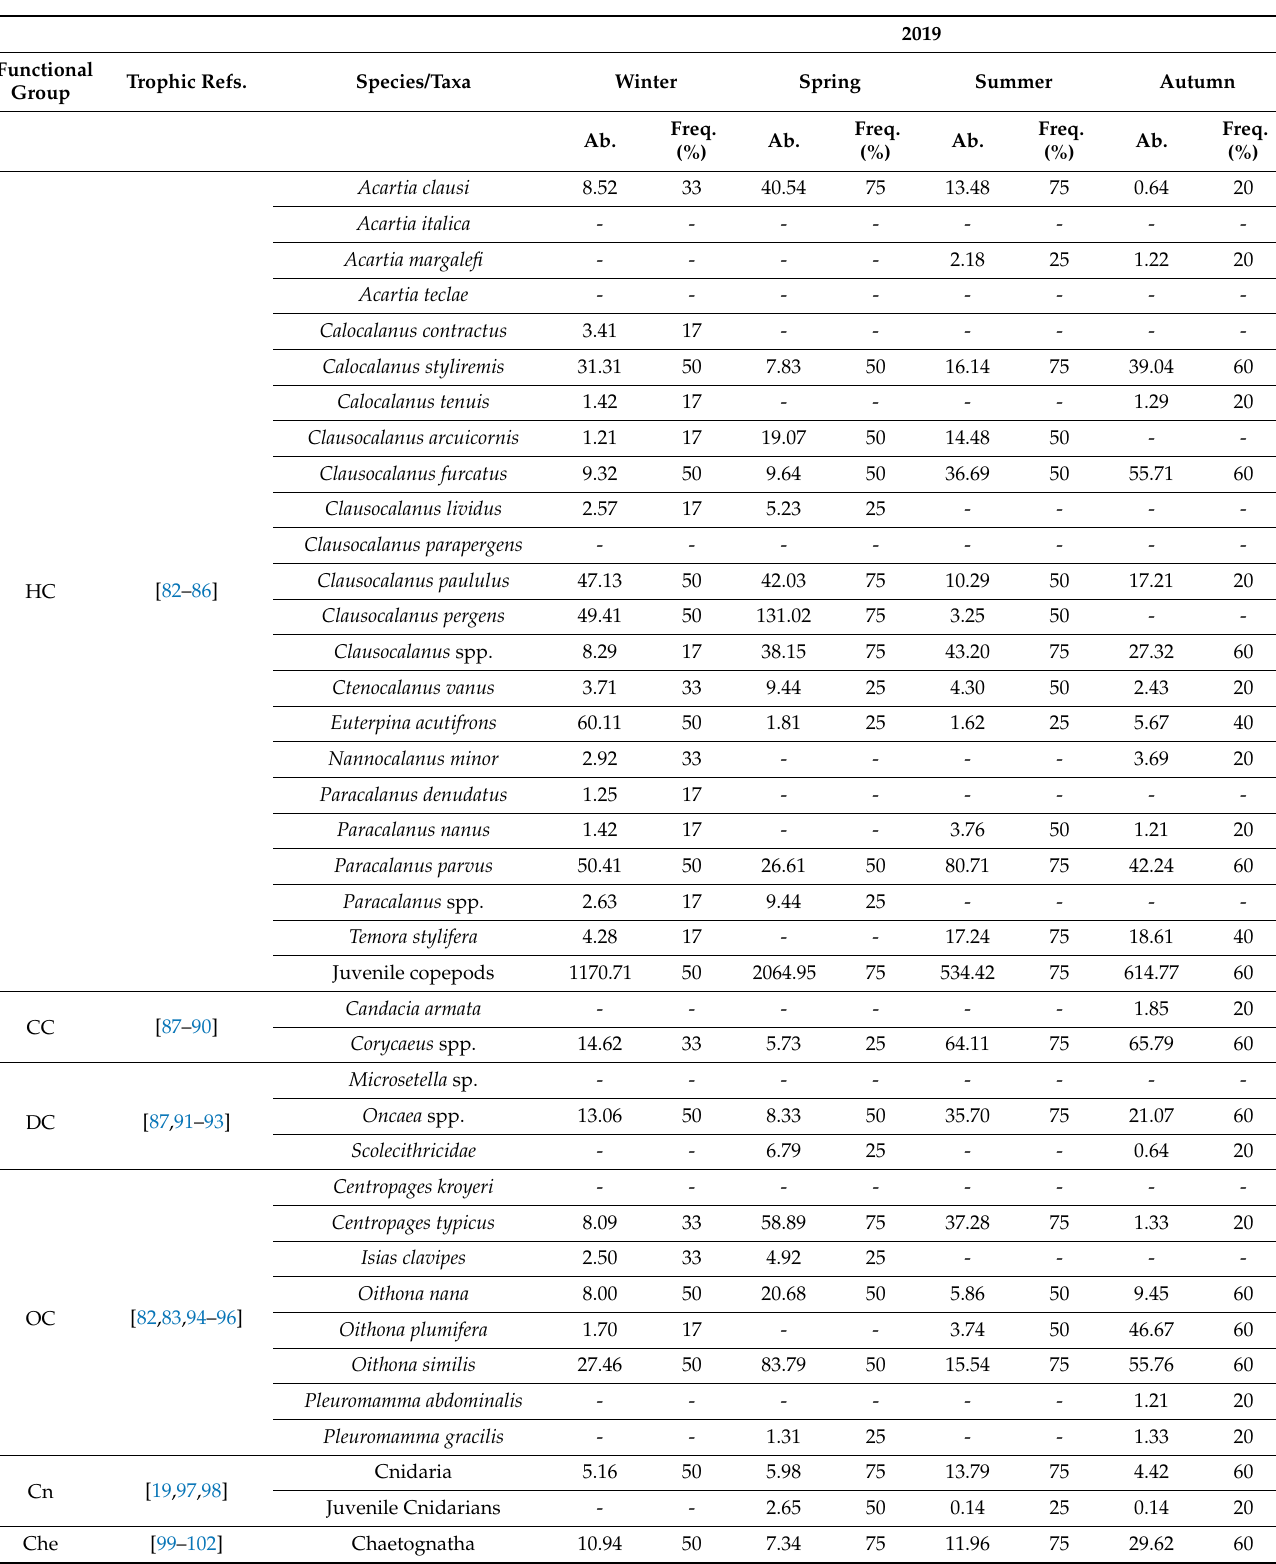
Table A7. Abundance and frequency of species in 2019